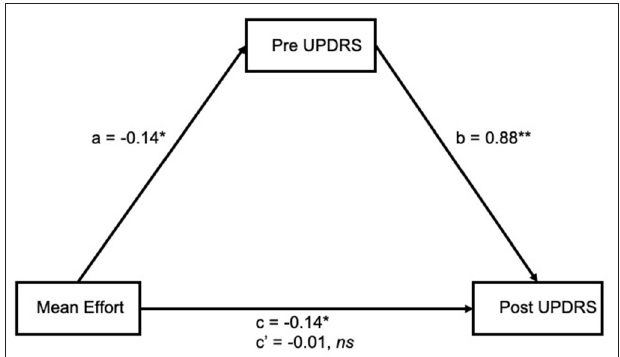
FIGURE 4 | Mean effort had a significant association with both pre (a) and post (c) UPDRS, and pre UPDRS with post UPDRS (b). The effect between mean effort and post UPDRS was fully mediated by pre UPDRS (c’). * p < 0.05 ** p <